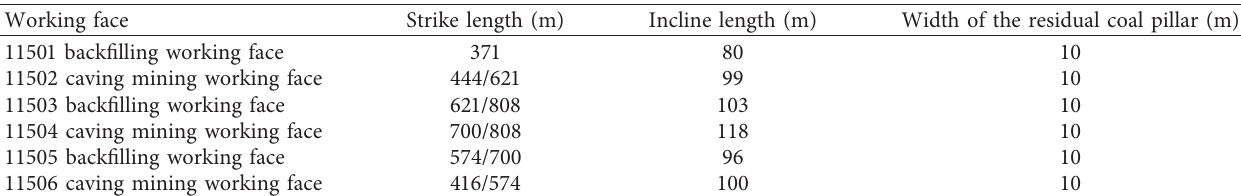
Figure 9: The layout of the backfill-strip mining working face. Table 1: Size of each working surface.